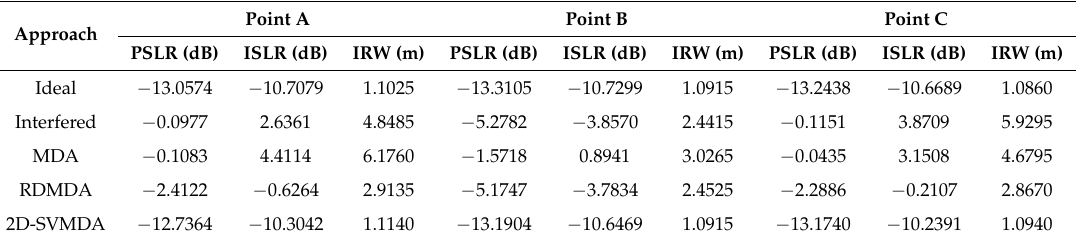
Figure 9. Azimuth impulse response curve comparison of Point A, B, and C. ( a ) Point A. ( b ) Point B. ( c ) Point C. Table 4. Statistical focus comparison of ideal, 2D spatial-variant error interfered, MDA processed, RDMDA processed, and 2D-SVMDA processed simulated point targets.